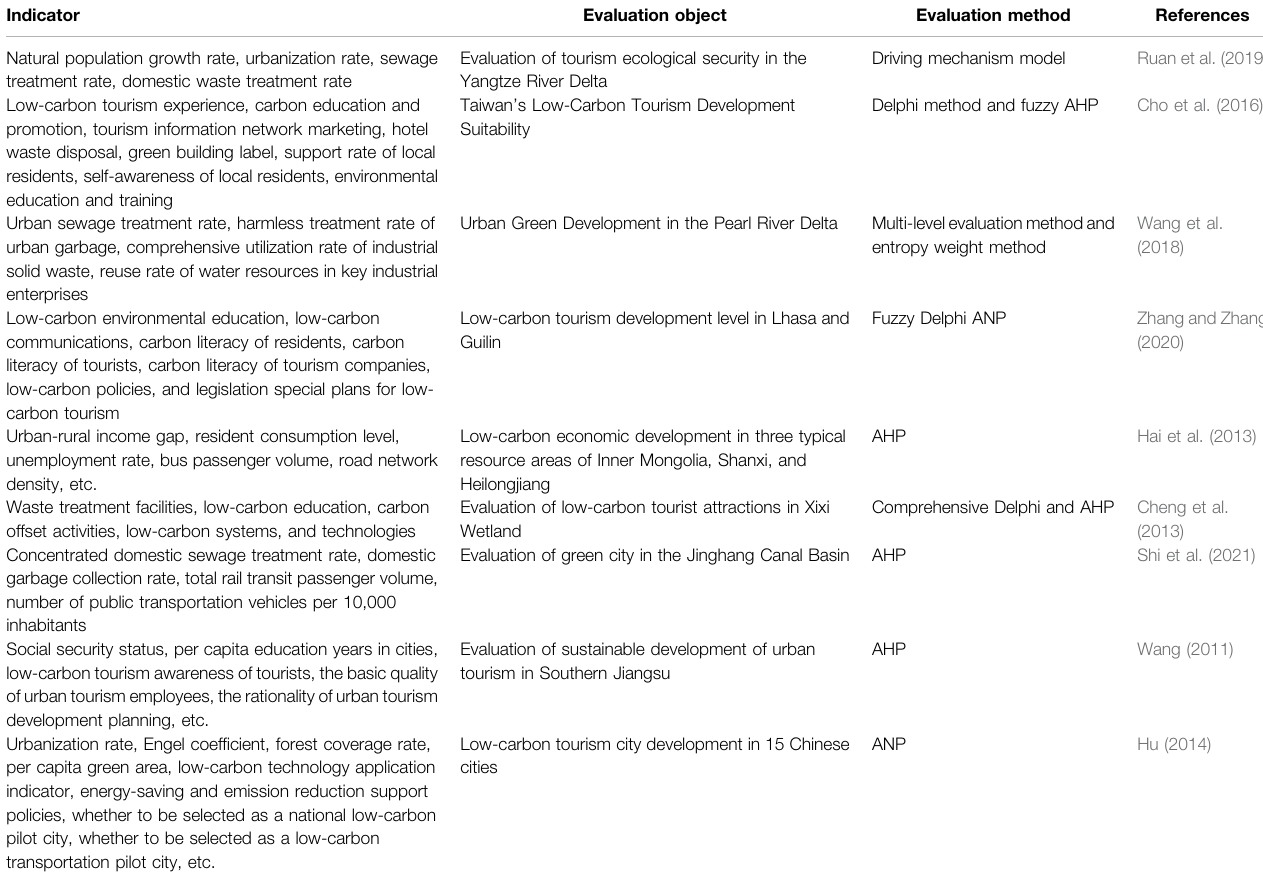
TABLE 3 | Indicators of social